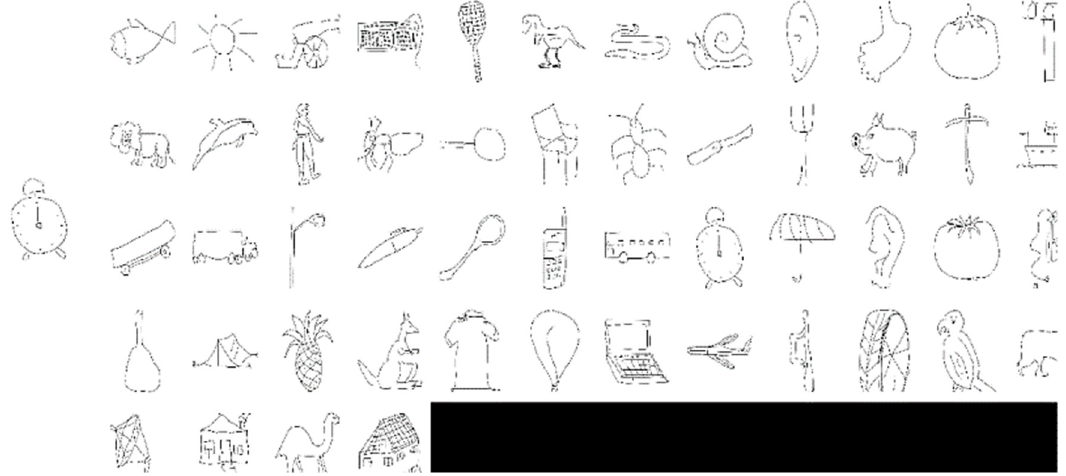
Figure 27. Query-retrieved image samples from TU Berlin dataset with InfoGAN retrieval system.